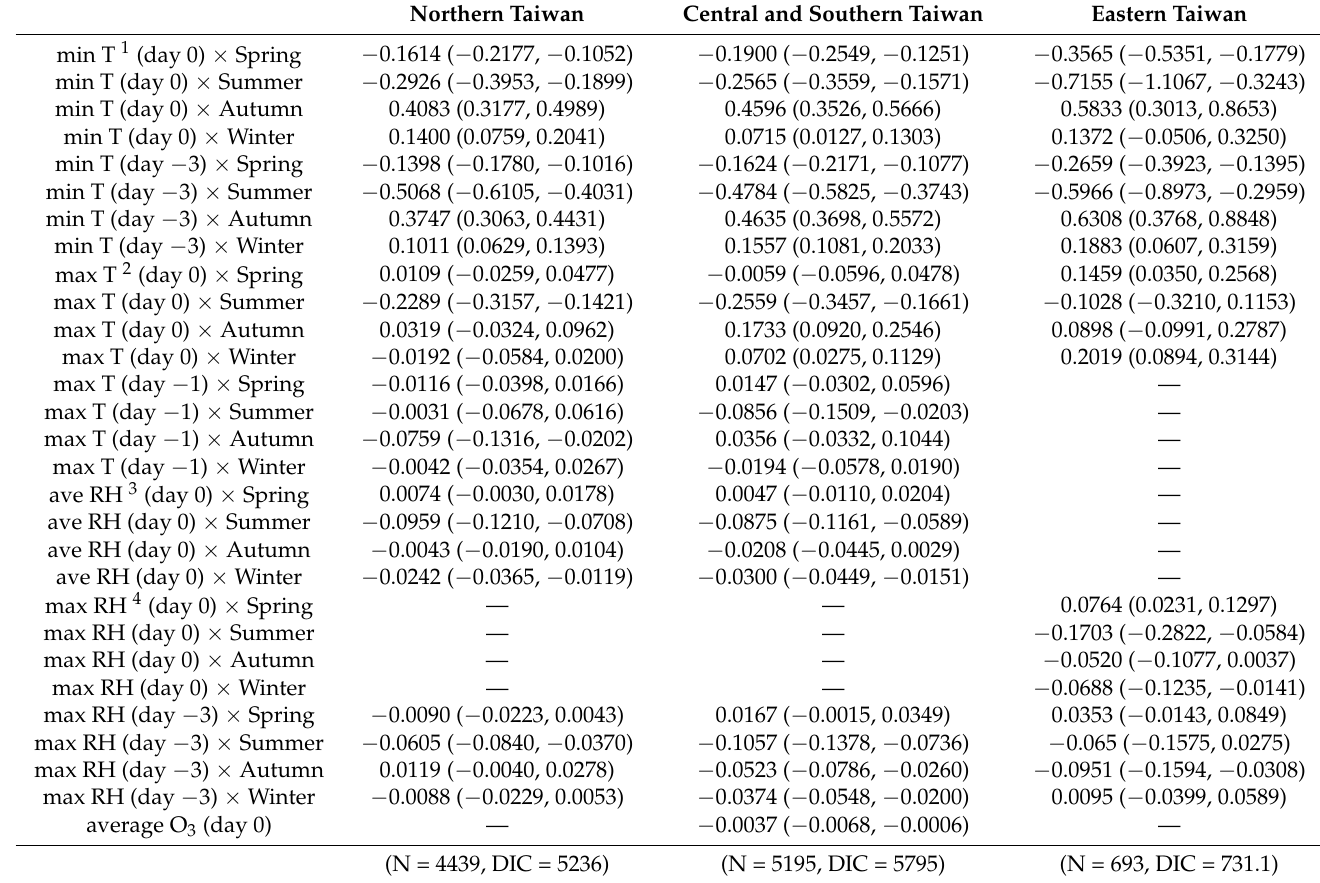
Table 1. Posterior mean and 95% credible intervals (CI) of regression coefficients for ischemic heart disease in Northern Taiwan, Central and Southern Taiwan, and Eastern Taiwan. Northern Taiwan Central and Southern Taiwan Eastern